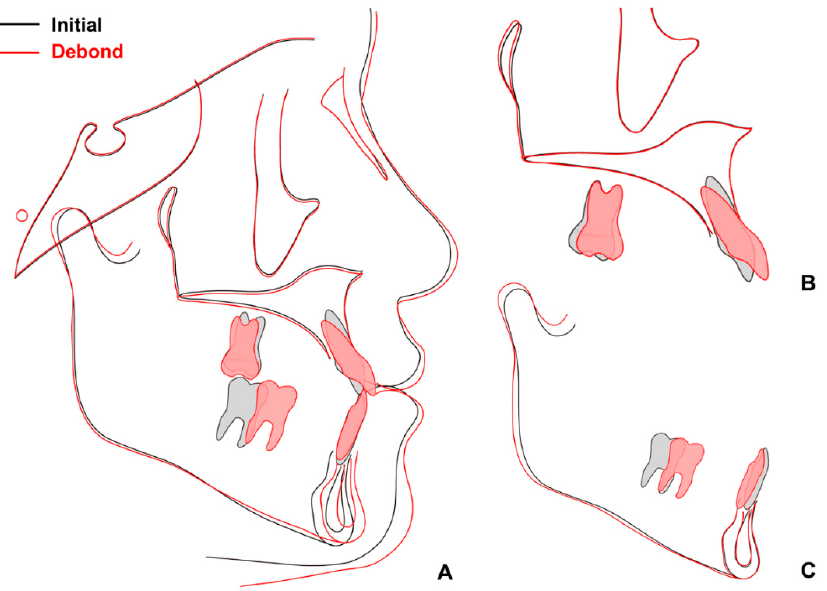
Figure 8. Superimposition before and after treatment: ( A ) total; ( B ) maxilla; ( C )